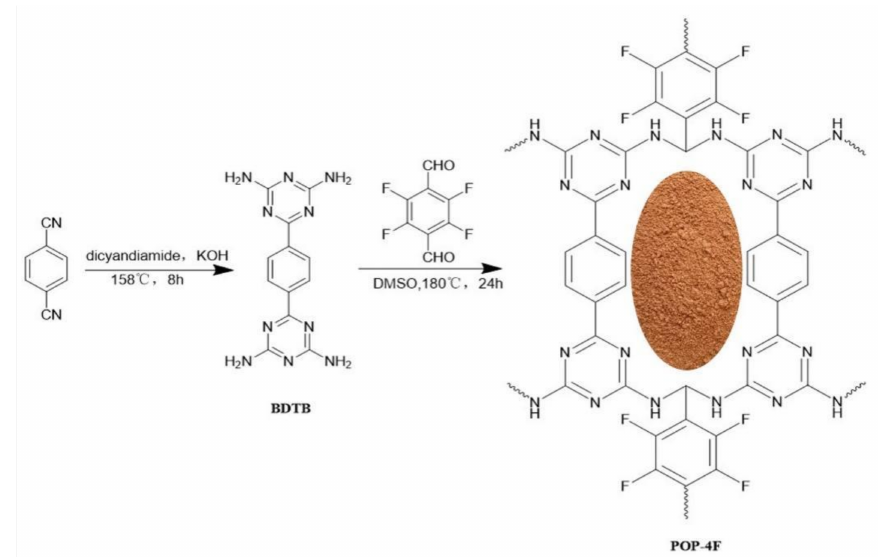
Figure 1. Synthesis Routes of